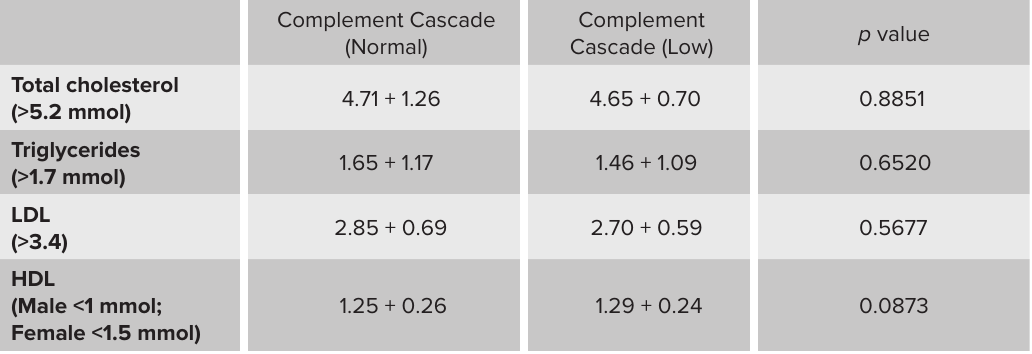
Table 6: The Relationship Between Dyslipidemia and Complements